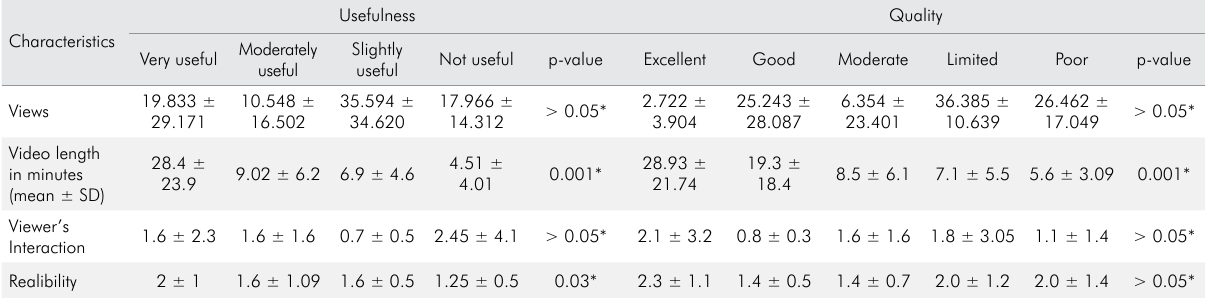
Table 3. Analyses of usefulness and quality assessment score in relation to length in minutes, views, viewer’s interaction, and reliability